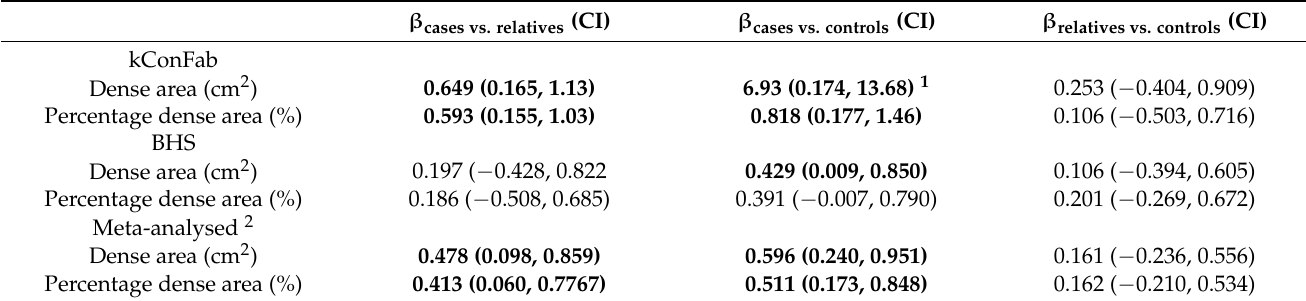
Table 3. Linear regression estimates ( β ) of the associations between the MBD measures and case-relative-control status.